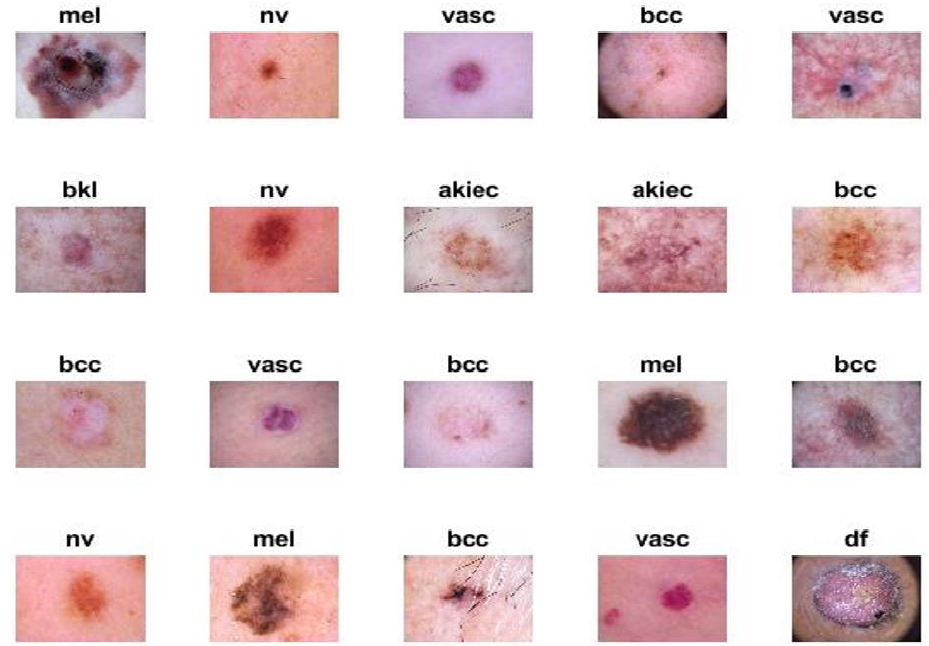
Figure 2. Samples of skin diseases obtained from the ISIC 2018 dataset.